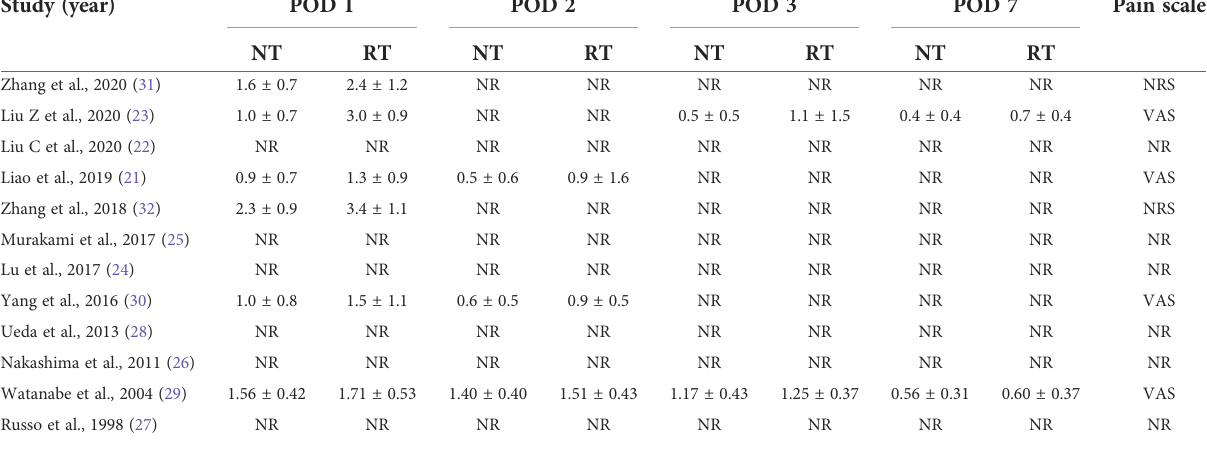
TABLE 4 Postoperative pain score of the included studies.